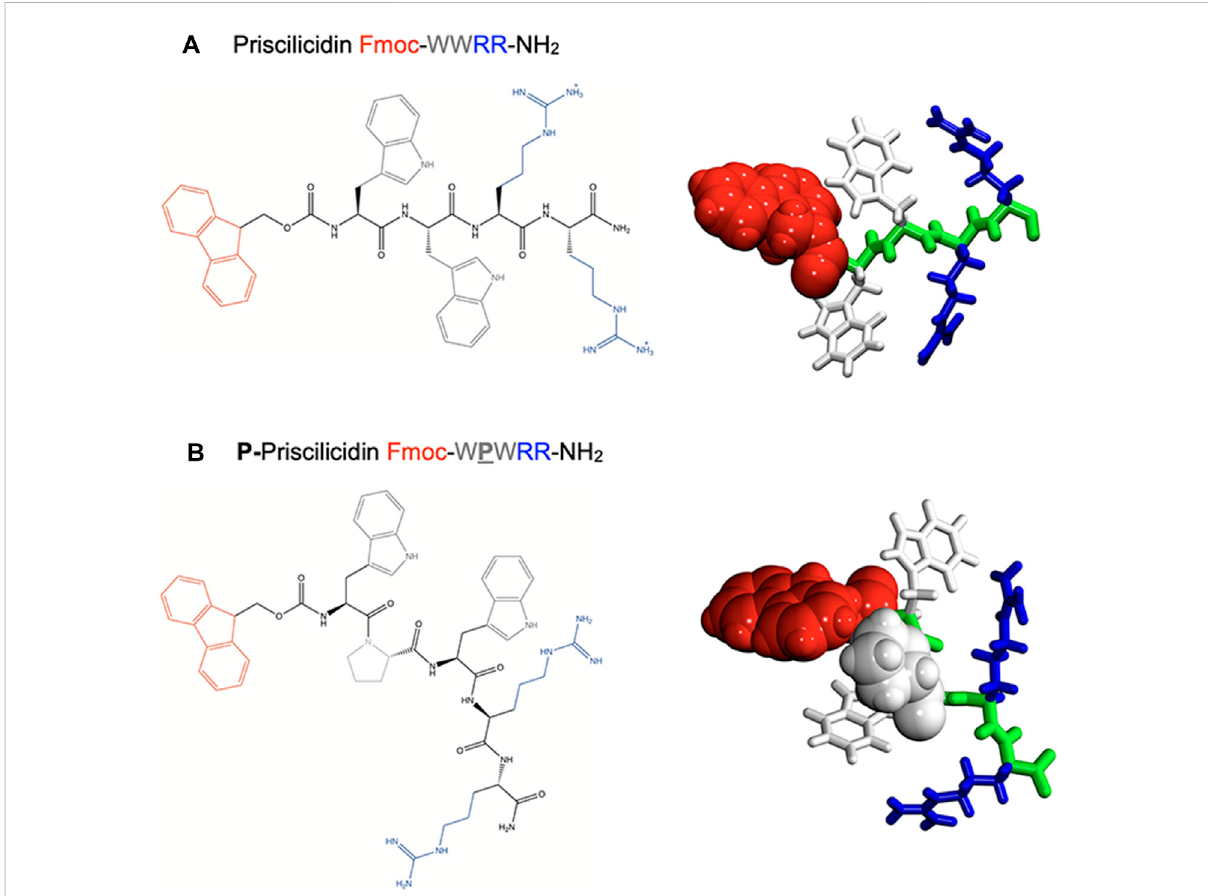
FIGURE 1 Molecular structure of the rationally designed peptides (A) Priscilicidin and (B) P-Priscilicidin. Left panel: developed amino-acid sequences. Right panels: ab-initio monomers for molecular dynamics